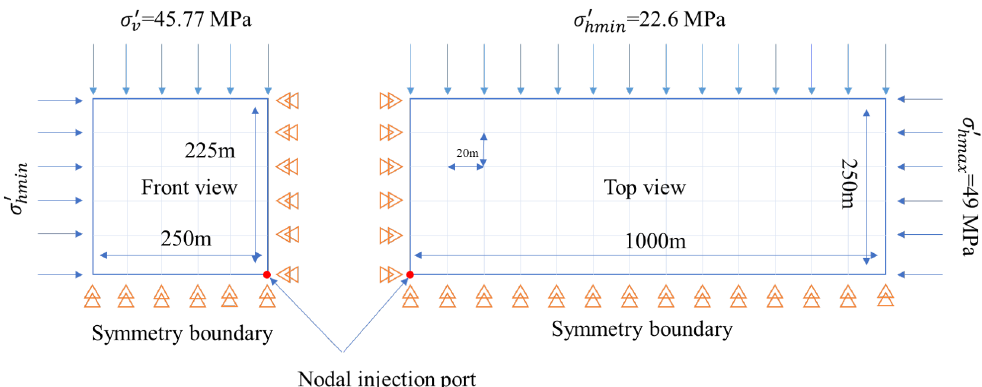
Figure 7. The boundary conditions and injection port location. The single headed arrows triangles indicate loading directions and symmetry surfaces, respectively. Red dot represents the location of injection